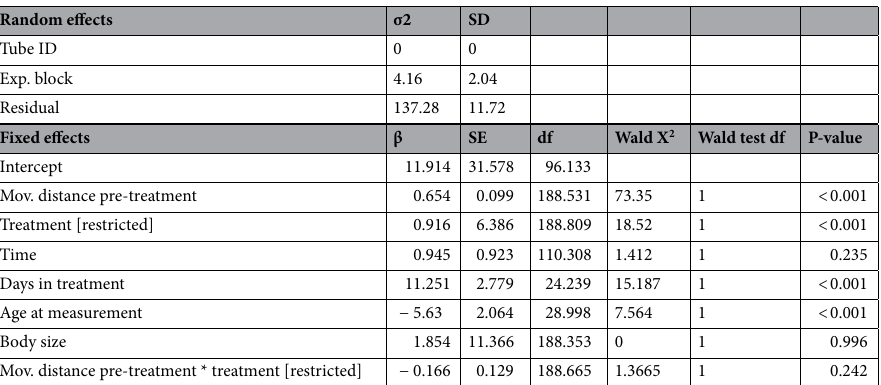
Table 3. Long-term experiment: result of a linear mixed model testing the treatment effects of resources limitation on activity measured after the treatment. Parameter estimates and SE were calculates using REML models. N Control = 95; N Restricted = 102.